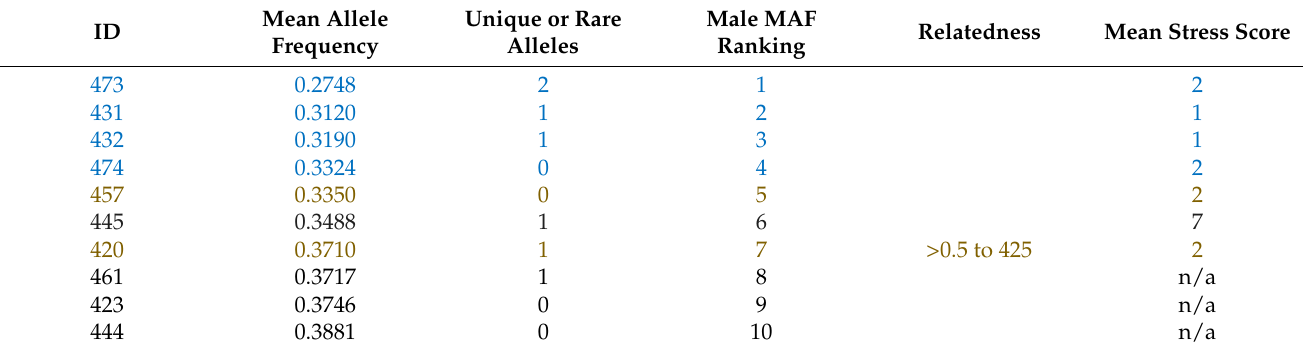
Table 1. Mean allele frequencies, number of unique or rare alleles, subsequent MAF rankings from number 1 (most uncommon alleles in their genotype) to 10 (most common alleles in their genotype), relatedness, and stress scores from number 1 (low) to 10 (high) for selection of male founders. IDs in blue were both proposed and used as founders, while gold were used as founders but not proposed as founders.